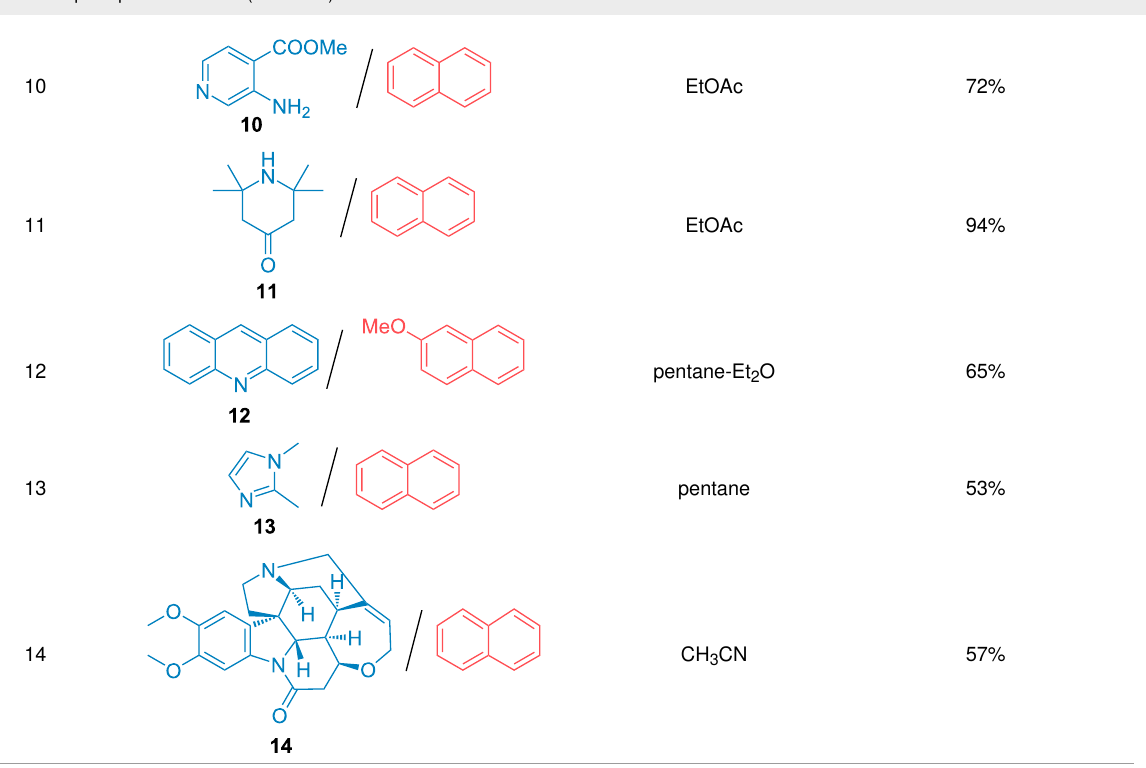
Table 3: Scope of purified amines.